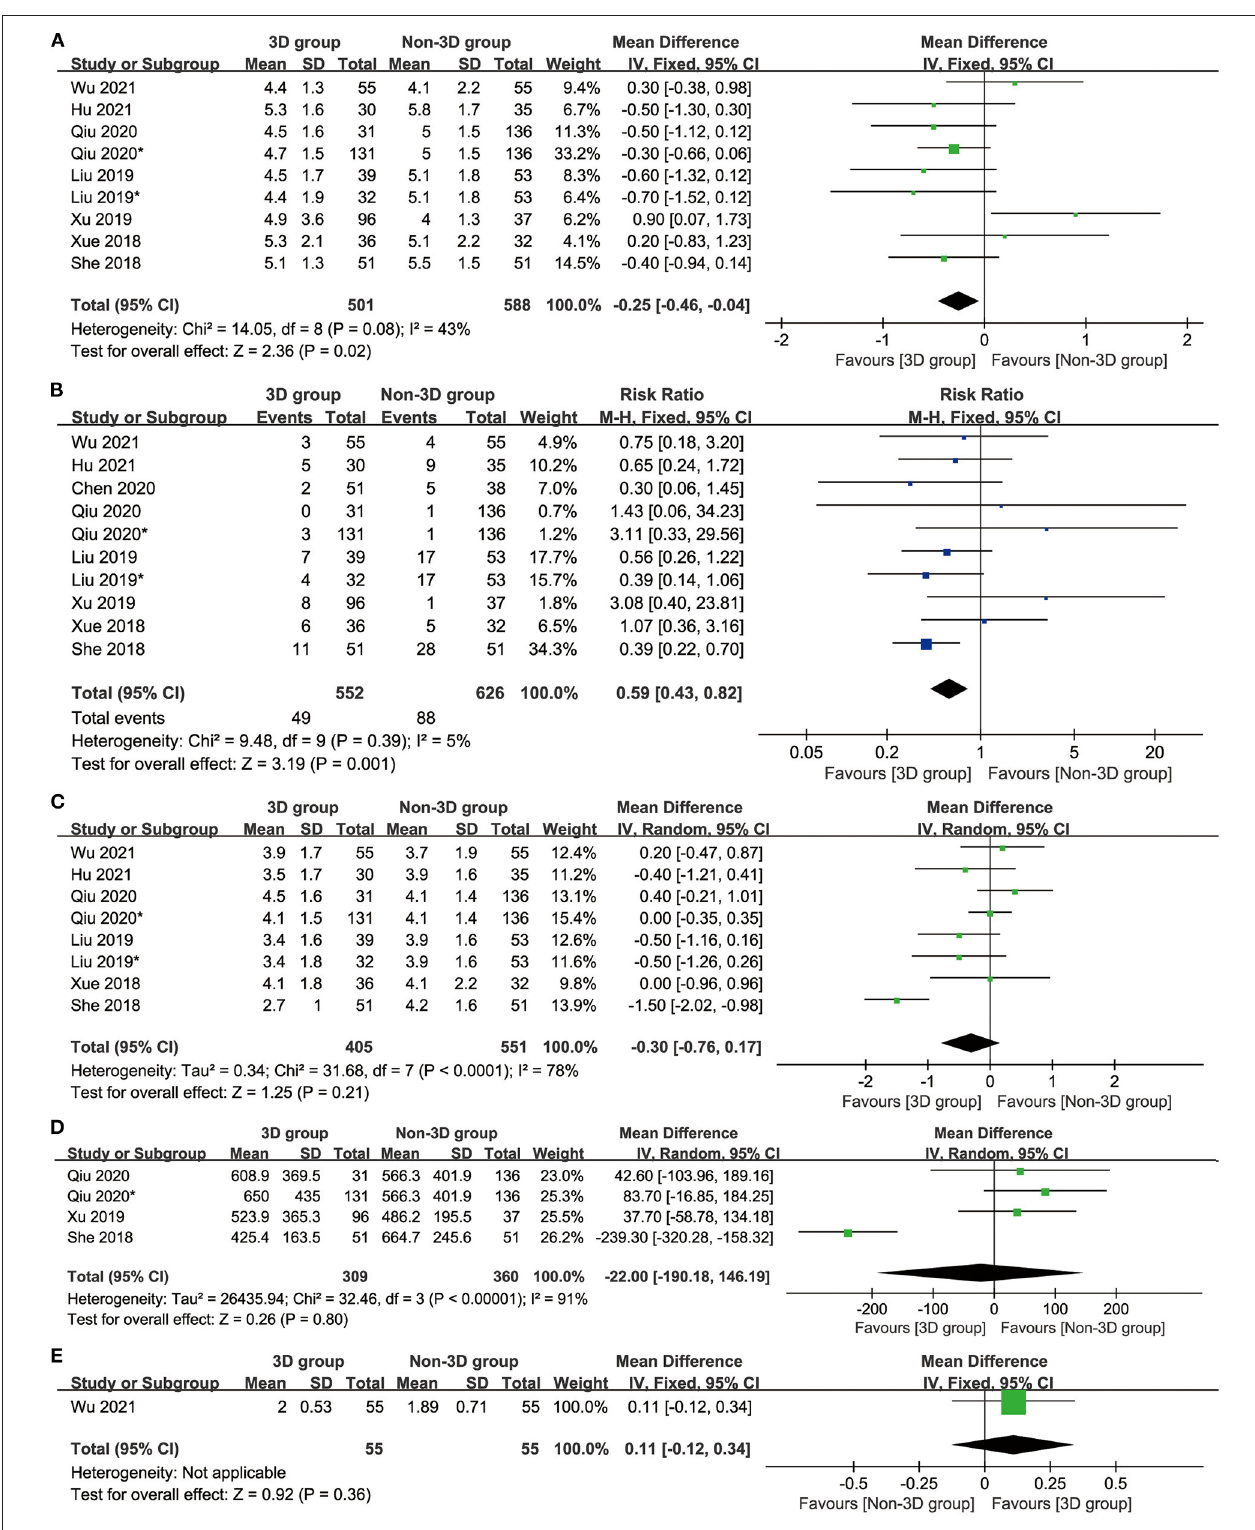
FIGURE 3 | Forest plots of hospitalization indicators: postoperative hospital stay (A) , complications (B) , postoperative drainage time (C) , postoperative drainage volume (D) , and postoperative Forced Expiratory Volume in the first second (E) .